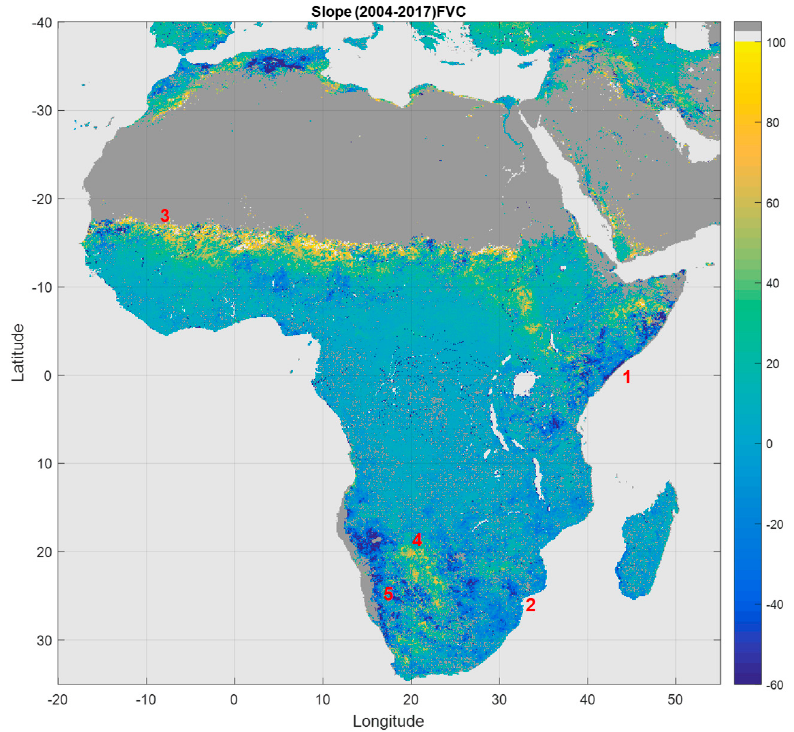
Figure 14. Trend of inter-annual changes over Africa derived by applying the MRA-WT method to 10-days FVC time series (2004-2017).